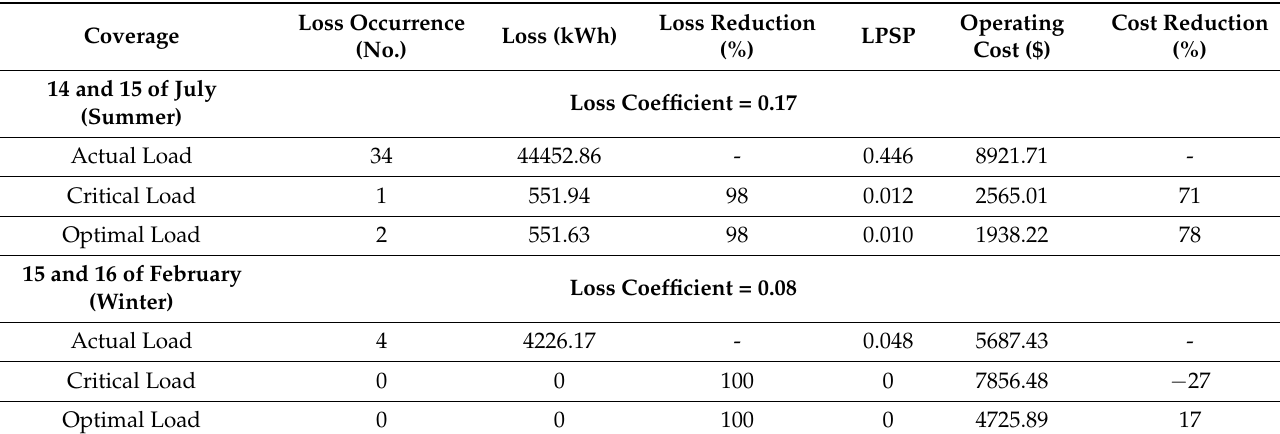
Table 6. Comparison of the scheduling results for the actual, critical, and optimal